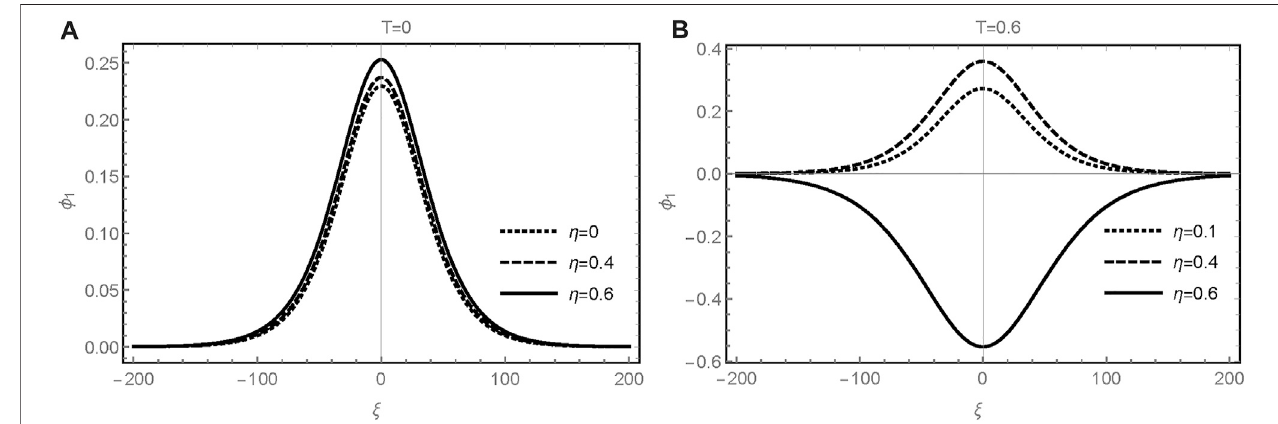
(cid:4)(cid:4)(cid:4)(cid:4)(cid:4) (cid:15) 1 − l 2 Z , U 0 (cid:1) 0.1, and Ω (cid:1)